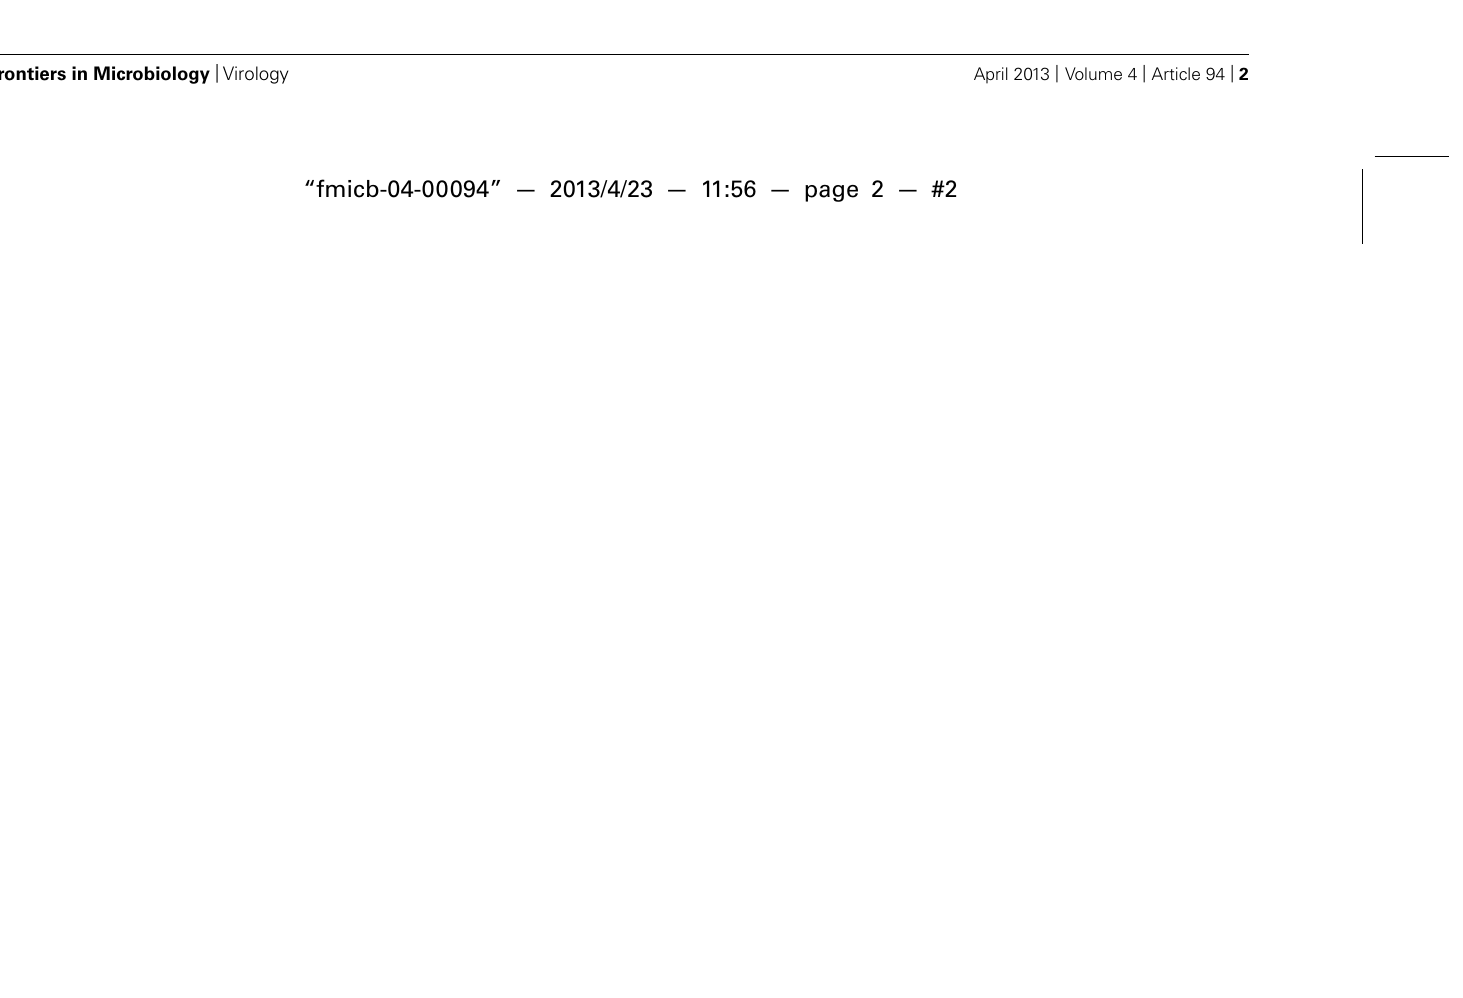
FIGURE 1 | Leaf symptoms of grapevine leafroll disease include inter-veinal reddening and leafrolling in red-fruited varieties. Symptoms are most pronounced around the harvest period.These photographs were taken in the fall (September) in Napa, CA, USA. Photographs show symptomatic leaf (A) , group of leaves (B) , and whole plant (C)